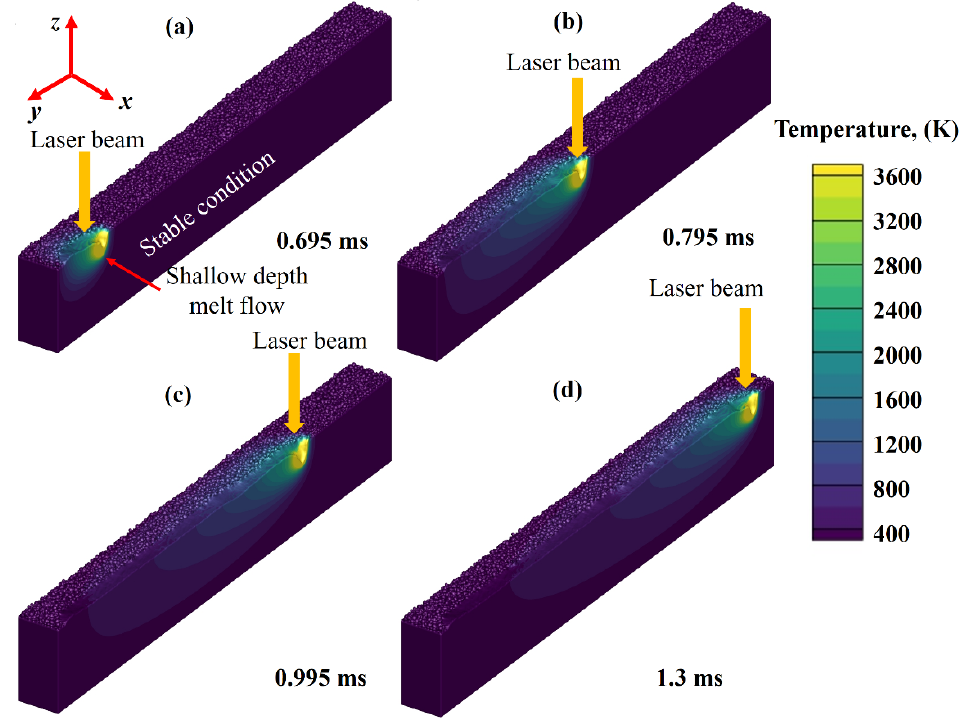
Figure 3. Temperature field contour formation at various time intervals ( a ) 0.695 ms, ( b ) 0.795 ms, ( c ) 0.995 ms and ( d ) 1.3 ms.